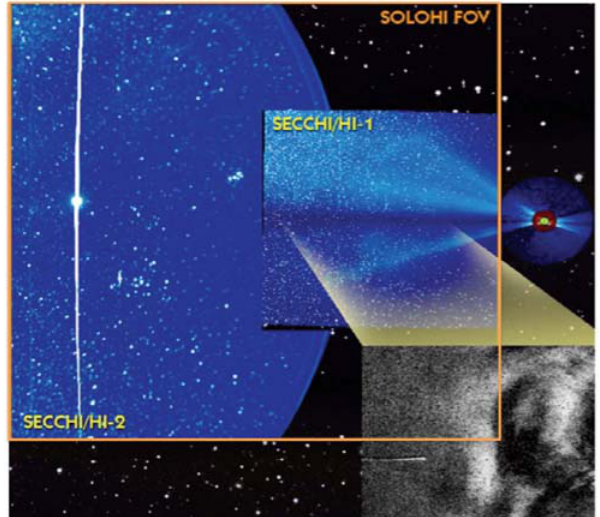
Figure 10. SoloHI field-of-view (FOV) from the Sun (red circle to the right) through the heliosphere, as compared with SECCHI’s Heliospheric Imagers HI-1 and